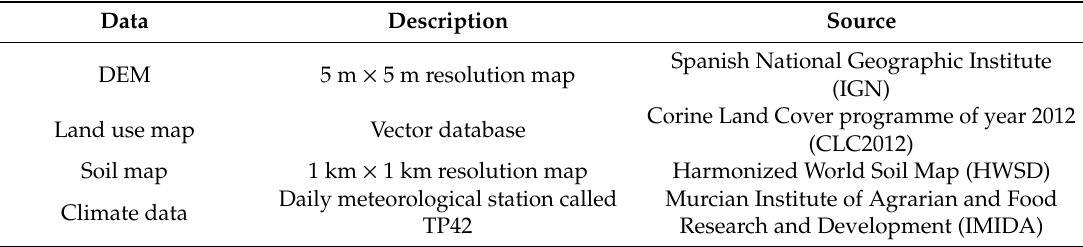
Table 1. List of input datasets used for model